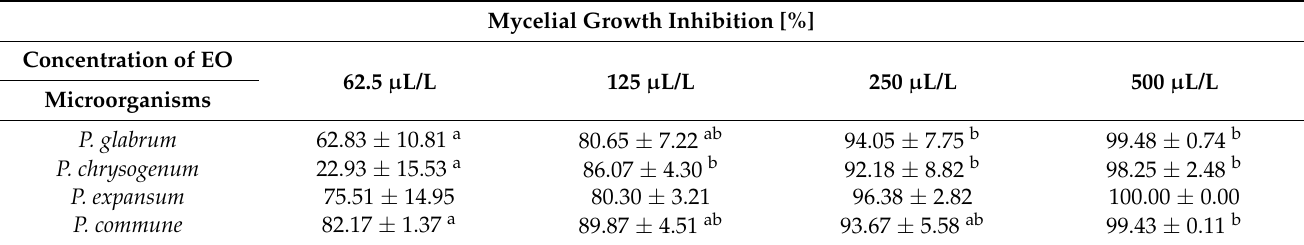
Means ± standard deviation. Values followed by different superscript within the same row are significantly different ( p < 0.05). The statistical differences ( p < 0.05) between individual EO concentrations were as follows: P. glabrum : 62.5 µ L/L vs. 250 µ L/L and 500 µ